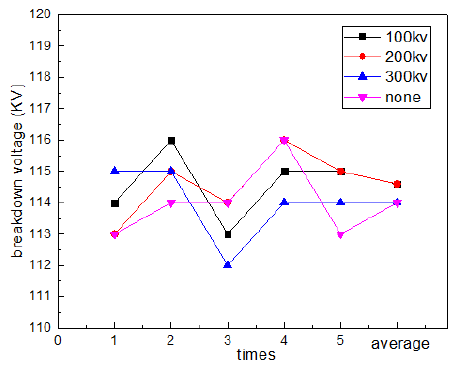
Figure 4. Complete photo of test tooling.